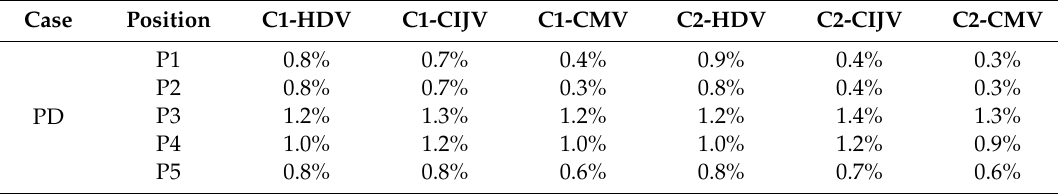
Table 3. Local discomfort (PD) due to high vertical air temperature between head and